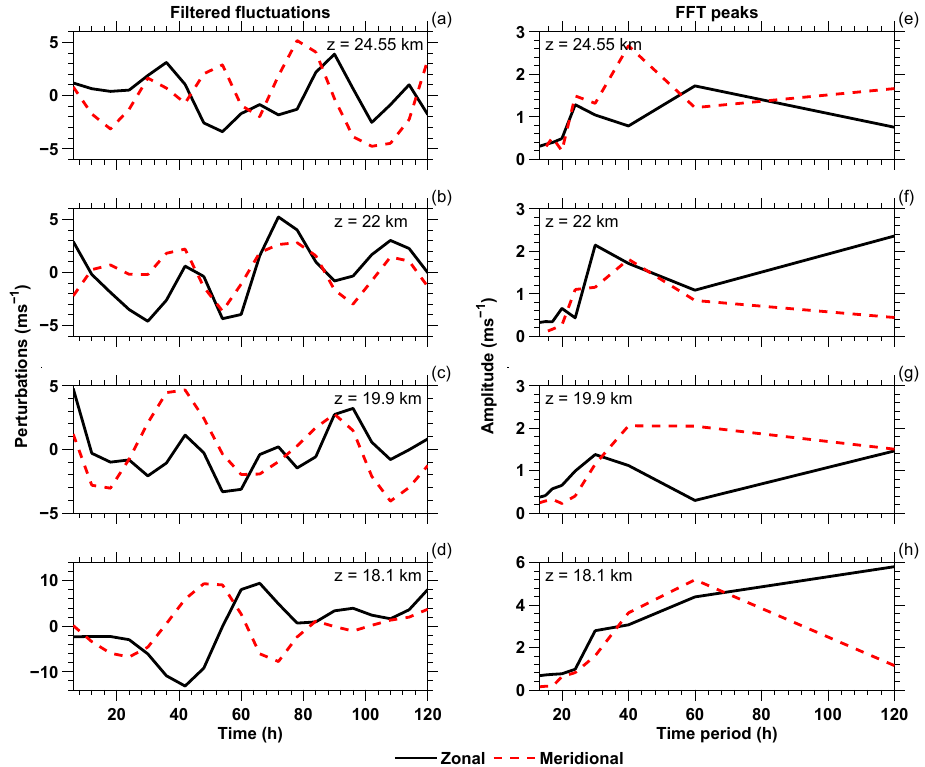
Figure 2. Same as Fig. 1, but with an FIR1